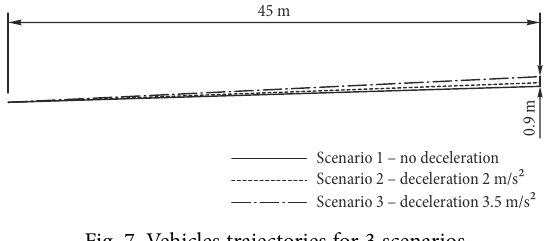
Fig. 7. Vehicles trajectories for 3